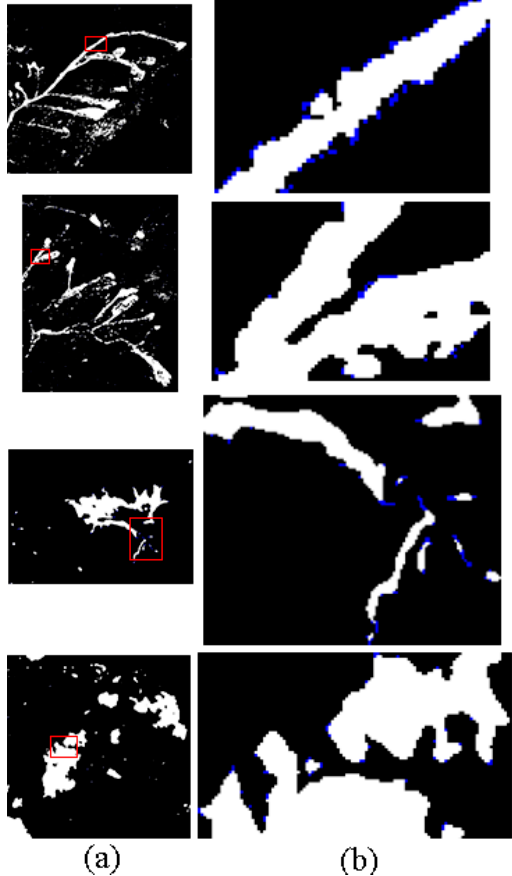
Figure 18. Growth performance based on the third technique (RGA) used to observe the details of the growth performance: ( a ) the selected observed range; and ( b ) the corresponding zoomed in figure. Blue, white, and black pixels represent the growing area, change region, and background, respectively.